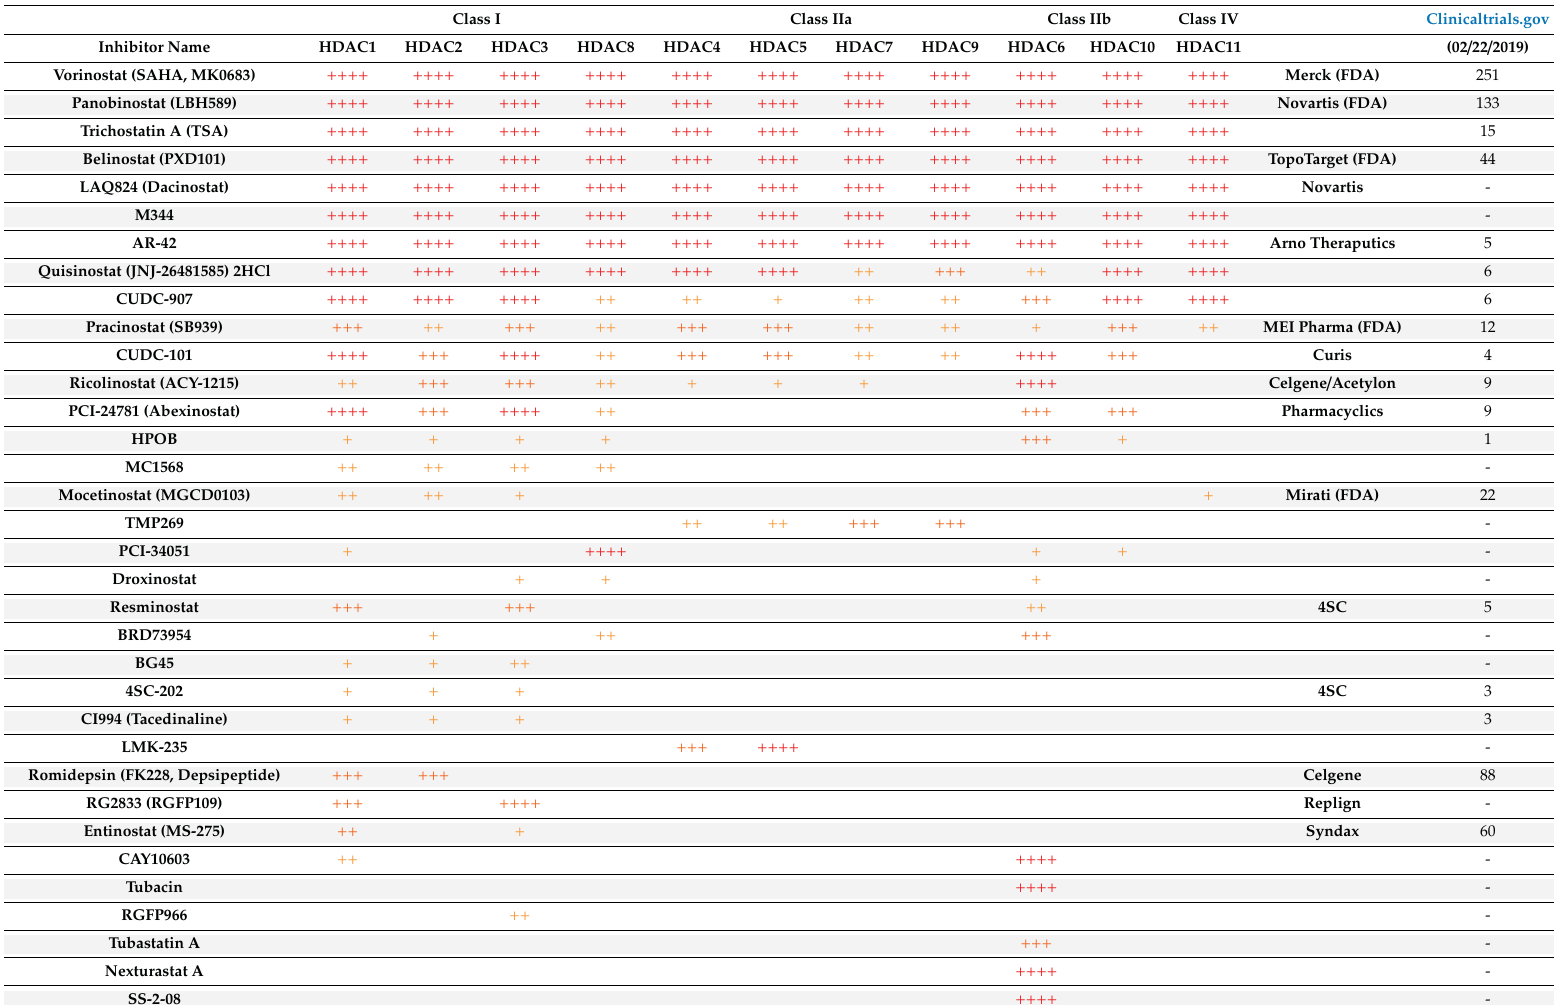
Table 1. Specificity and application of pan and selective